Question: Which kind of chart has been used to present this data?
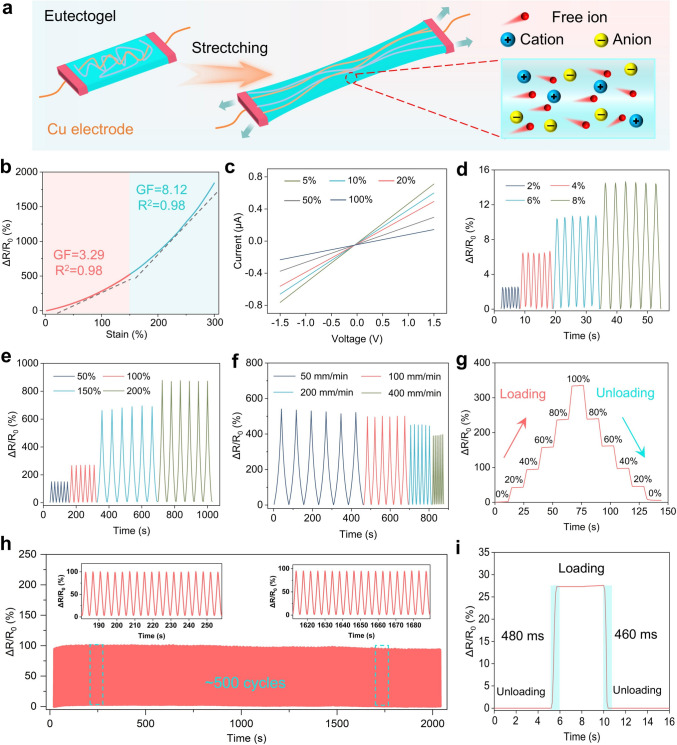
Answer: line